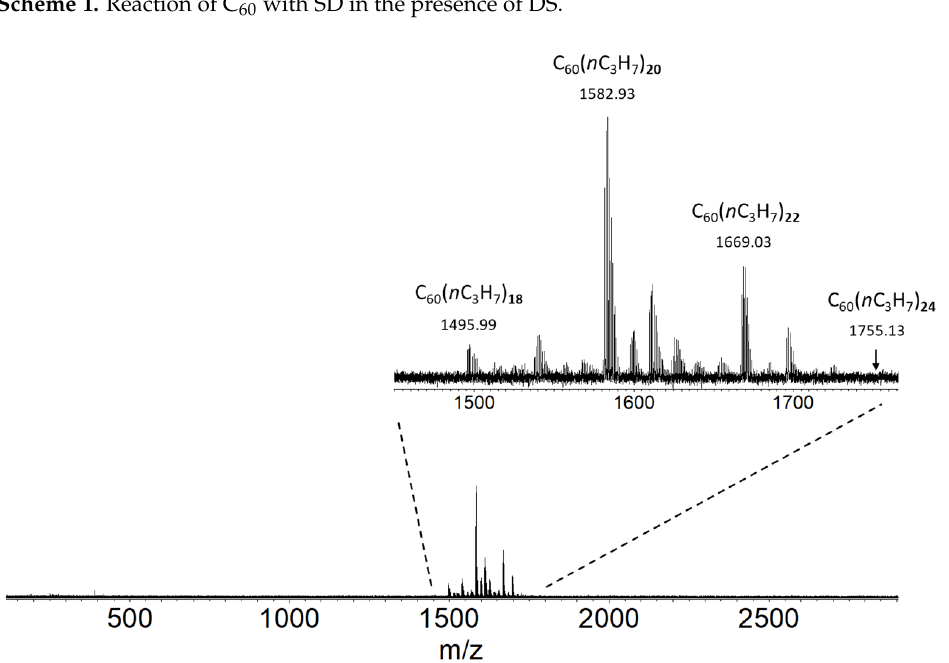
Figure 2. DART-MS (positive) of the obtained mixture of C 60 ( n C 3 H 7 ) n .